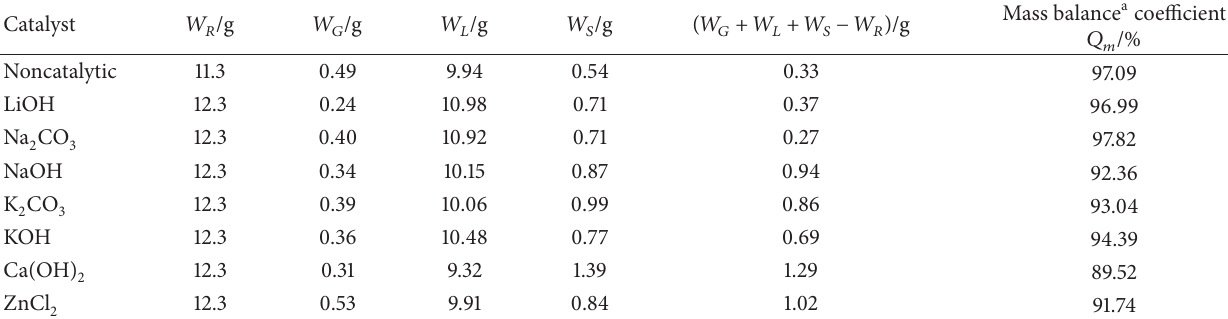
Table 3: Mass balance for homogeneous catalyst investigation.